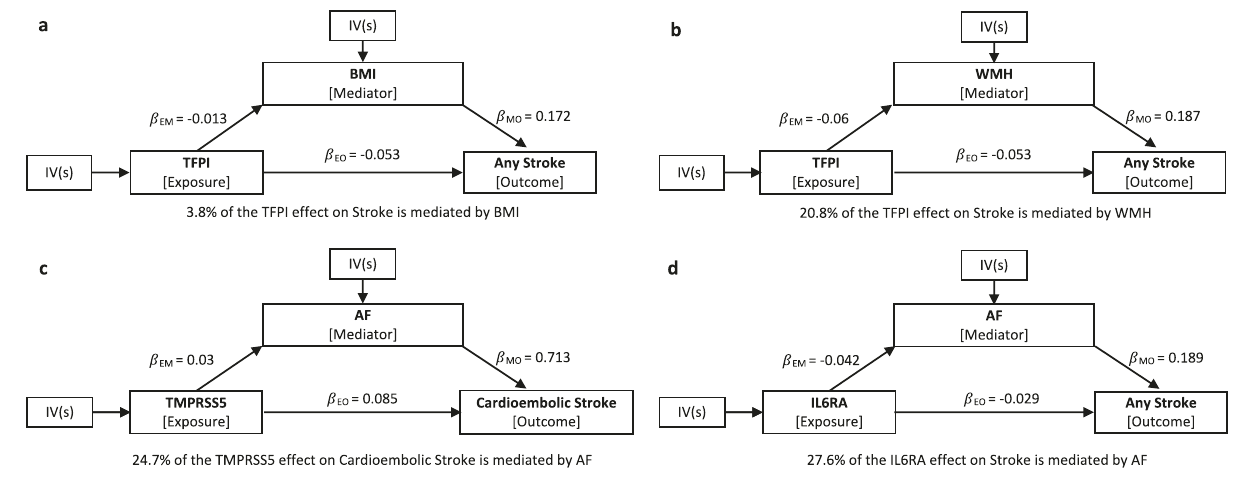
Fig.6|Mediationeffectsofproteinonstrokeviariskfactors. Mediationanalyses to quantify the effects ofthree proteins on strokeoutcomes viarisk factors. a TFPI effect on stroke mediated by BMI. b TFPI effect on stroke mediated by WMH; c TMPRSS5 effect on cardioembolic stroke mediated by AF; d IL6RA effect on